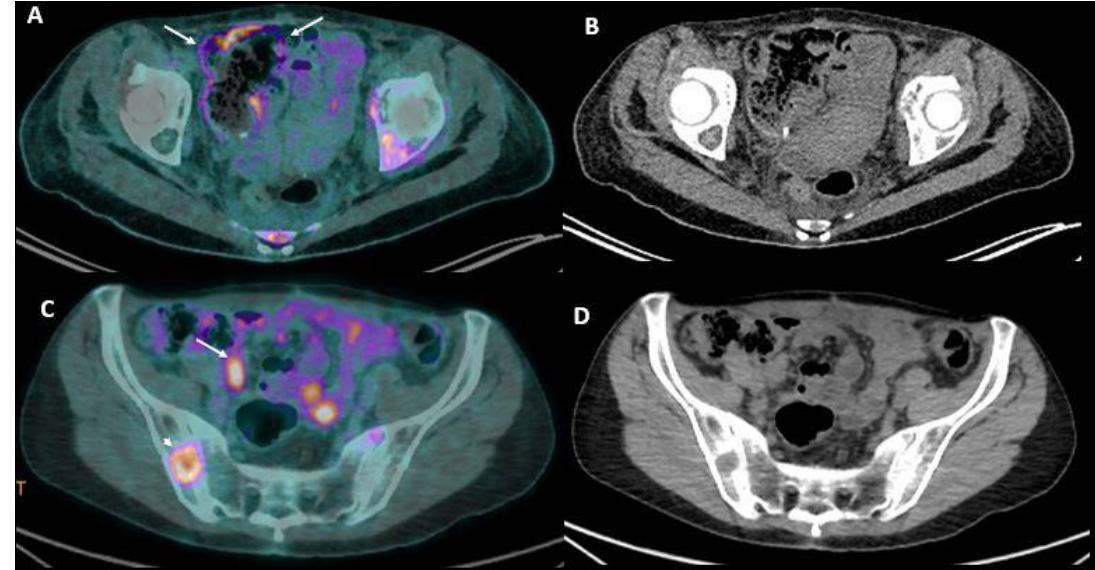
Figure 4. A 45-year-old female patient with peritoneal carcinomatosis from diffuse cell type gastric cancer. PET-CT fusion ( A , C ) with corresponding native CT images ( B , D ) shows evidence of linear FDG uptake of the caecum surface ( A , arrows) and focal uptake within the pelvic peritoneum ( C , arrow), both corresponding to peritoneal carcinomatosis. Note the presence of focal FDG uptake in iliac bone corresponding to a biopsy-proven metastasis ( C , arrowhead). PET: position emission tomography.